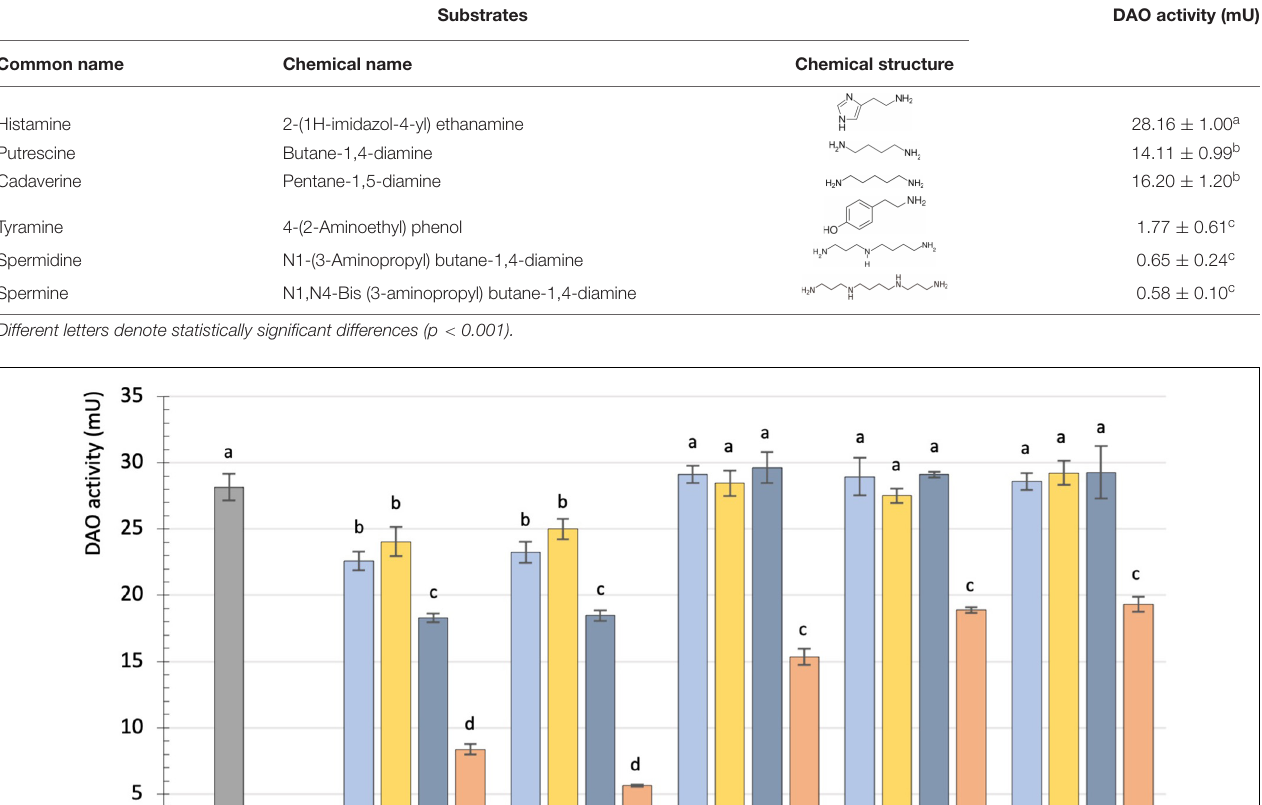
TABLE 1 | Enzymatic activity (mU) of porcine diamine oxidase (DAO) (mean ± SD ) on different amino substrates. Substrates